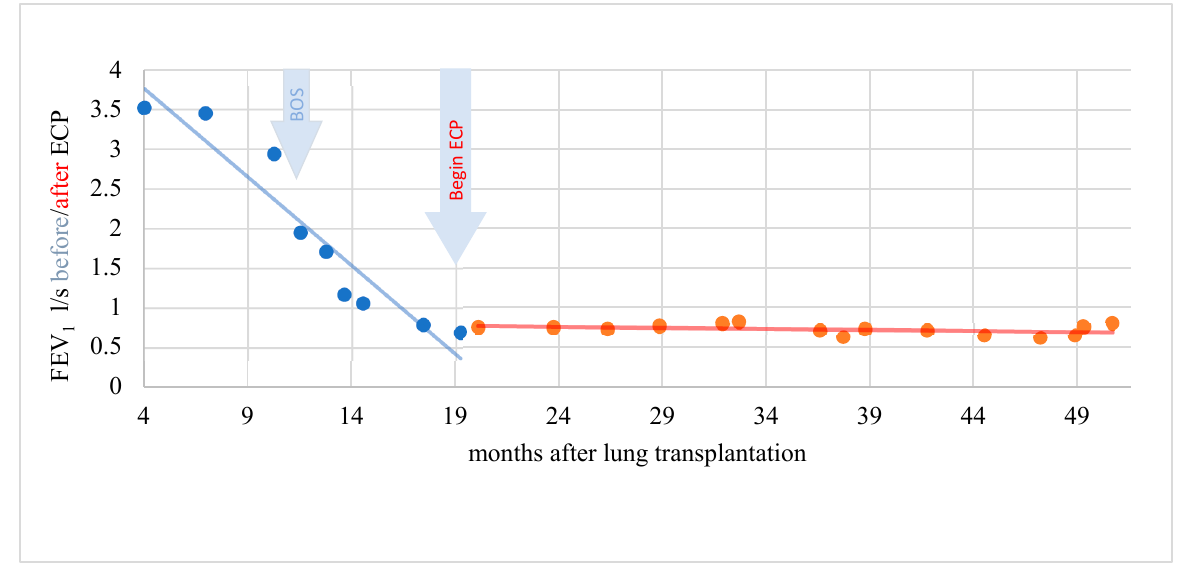
Figure 4. Complete response of a patient with BOS to ECP. Lung function and FEV1 stabilized. In a period of 15 months before the start of ECP, the rapidity of FEV1 reduction was on average–0.229 l/s/month (standard deviation 0.305). A further decline in lung function could be stopped during therapy with ECP and the FEV1 even increased by an average of 0.011 l/s/month (standard deviation 0.049) over a treatment period of 31 months. This dif- ference was statistically significant (t = − 2.346; p = 0.046). In another patient, the rapidity of FEV1 reduction was distinctly reduced under ECP. The difference, however, was not statistically significant (t = − 1.903; p = 0.123) and the response was therefore evaluated clinically objectifiable but statistically not significant (Figure 5).